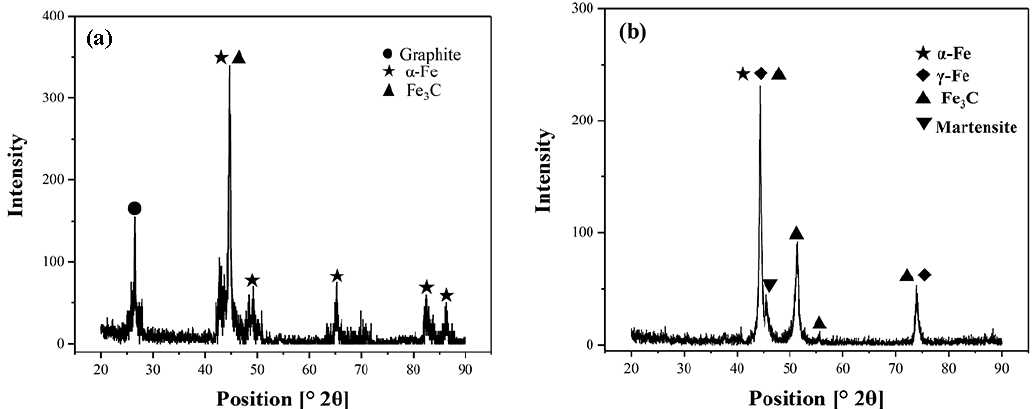
Figure 10. X-ray diffraction pattern taken from the surface of ( a ) untreated sample and ( b ) bionic blocked unit.